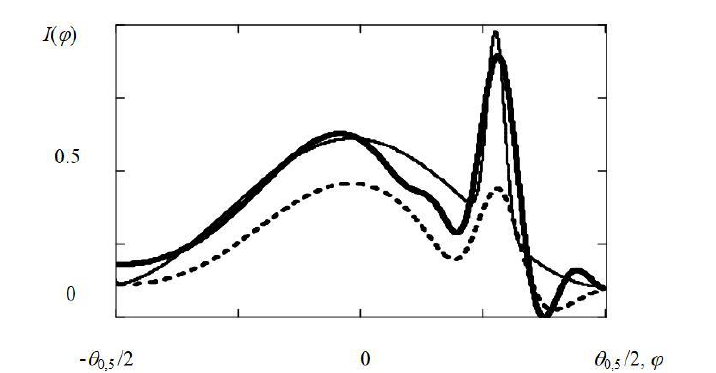
Fig. 5. The reconstructed image of the source using DOG